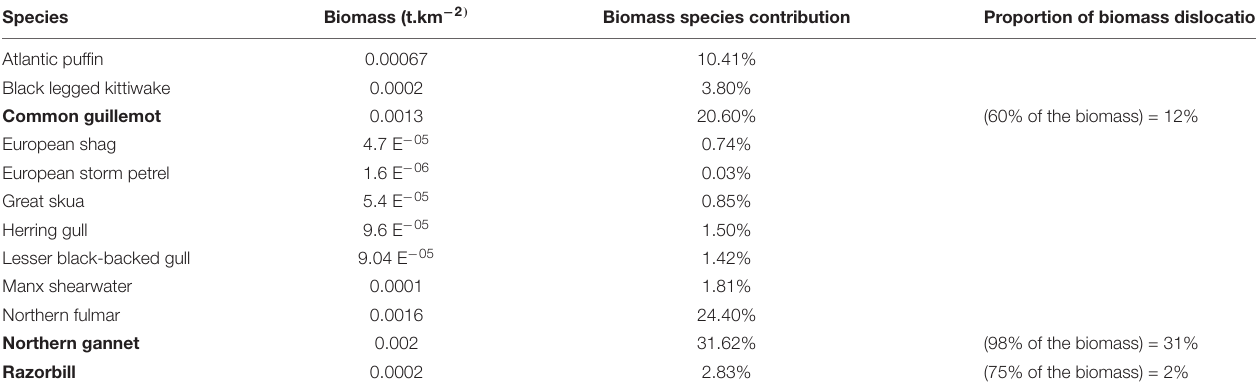
TABLE 1 | Seabirds functional group composition, biomasses, species contributions, and proportion of biomass dislocation for the three species (in bold) showing significant avoidance of wind farms. Species